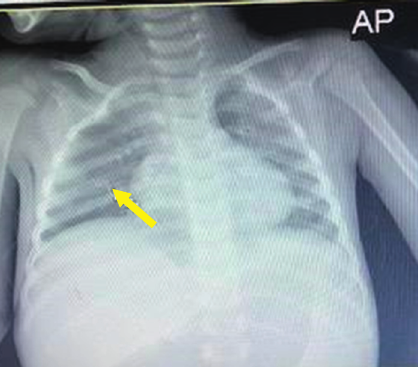
Figure 2: Chest radiography AP